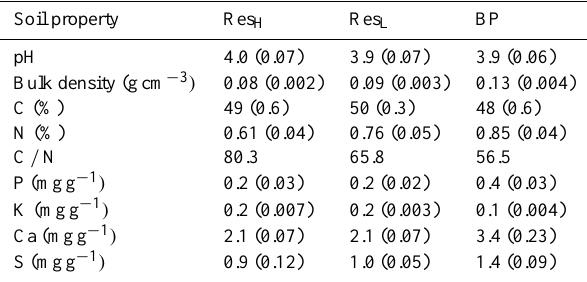
Table 1. Soil properties in restoration treatments with high (Res H ) and low (Res L ) water table level and bare peat (BP); numbers in parenthesis indicate standard